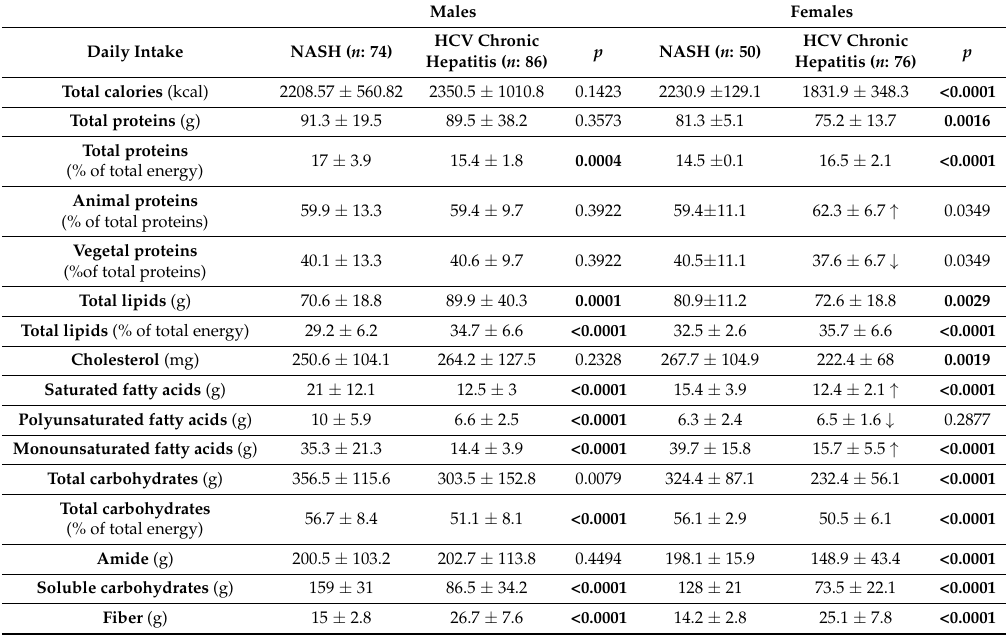
Table 6. Intake of macronutrients in study population in males and females (NASH versus HCV-chronic hepatitis (Mean ± SD)).